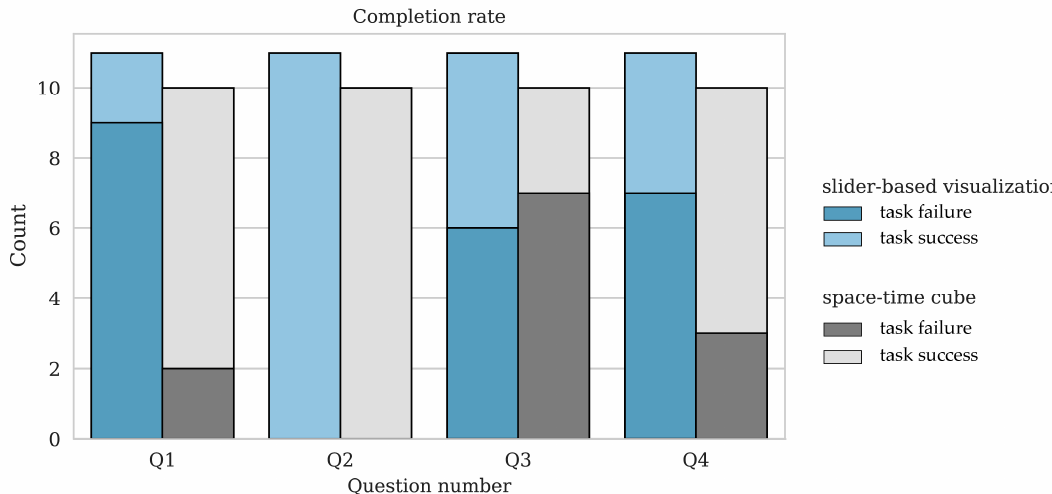
Figure 7. Completion rate for benchmark tasks for tested applications: the slider-based visualization and the space–time cube.